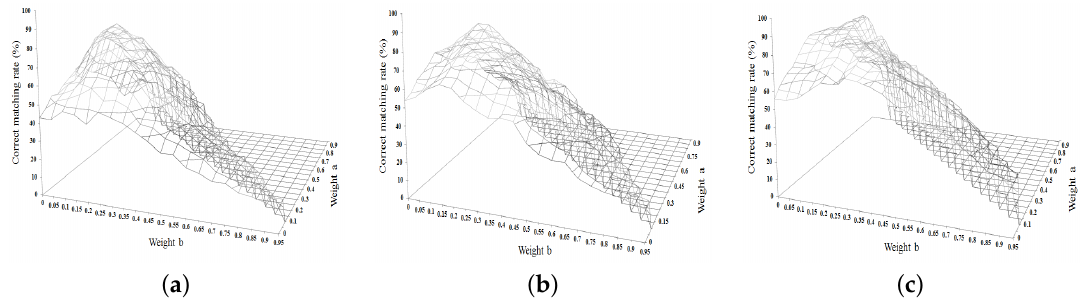
Figure 13. Experimental results using different weight values: ( a ) the statistics of the correct matching rate using an image pair (Figure 1a,b); ( b ) the statistics of the correct matching rate using an image pair (Figure 1c,d); ( c ) the statistics of the correct matching rate using an image pair (Figure